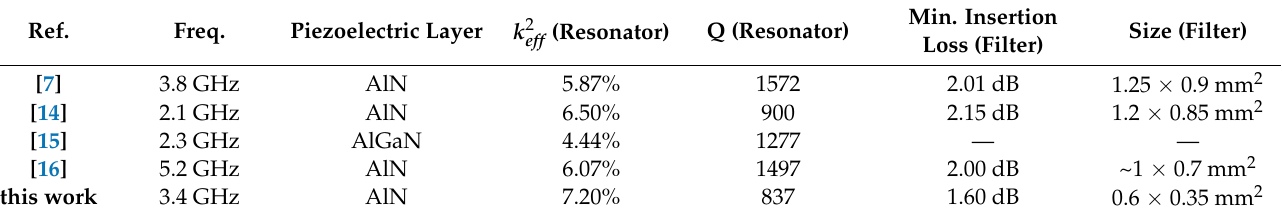
Figure 9. ( a ) Simulated relationship between the change of center frequency and trimming thick- nesses of top passivation AlN on both series and shunt resonators; ( b ) simulated relationship be- tween filter 3-dB bandwidth and trimming thicknesses of top passivation AlN on series or shunt resonators.